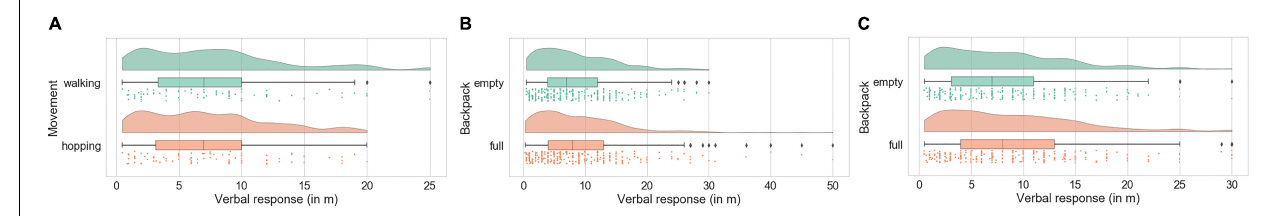
FIGURE 4 | Participants’ distance estimates in Experiment 2 (A) , 3 (B) , and 4 (C) . Distributions show responses in different effort conditions under which individual data points are vertically jittered. Boxes indicate interquartile range with median, whiskers show 1.5 interquartile range (modified from Allen et al.,